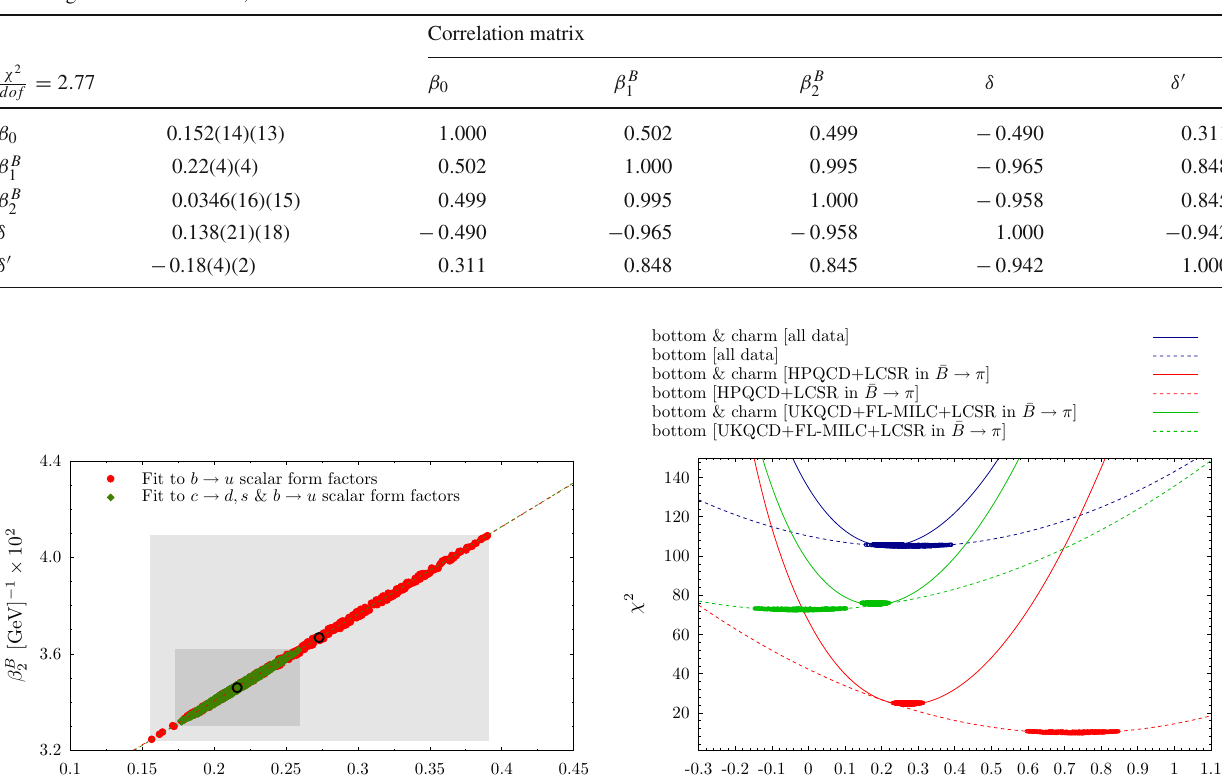
( β B ) are given in units 1 2